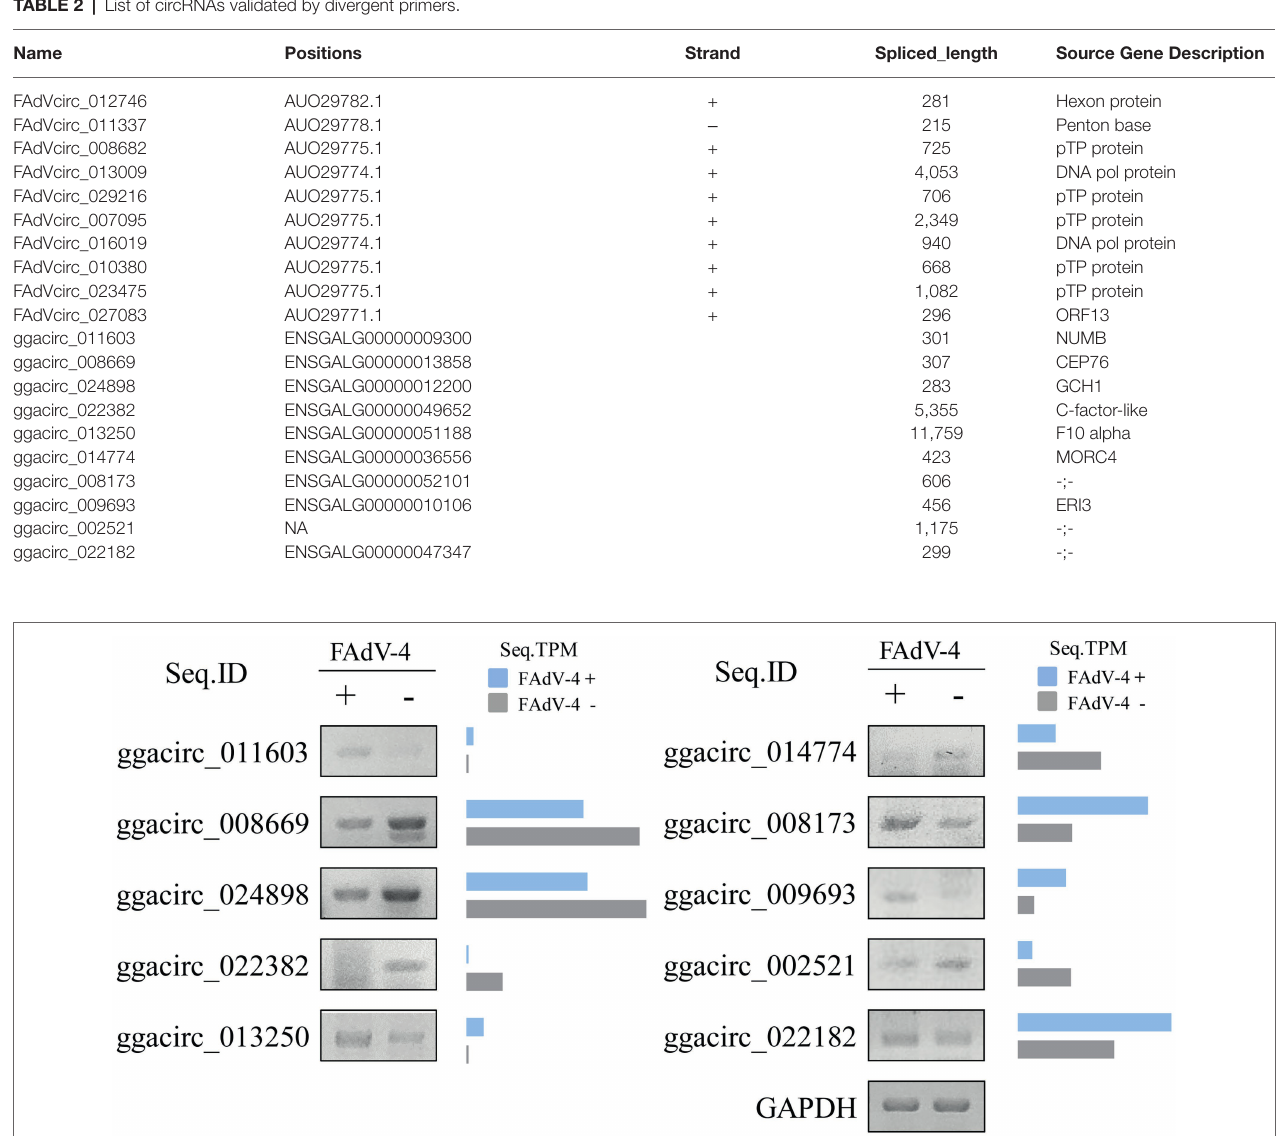
TABLE 2 | List of circRNAs validated by divergent primers.